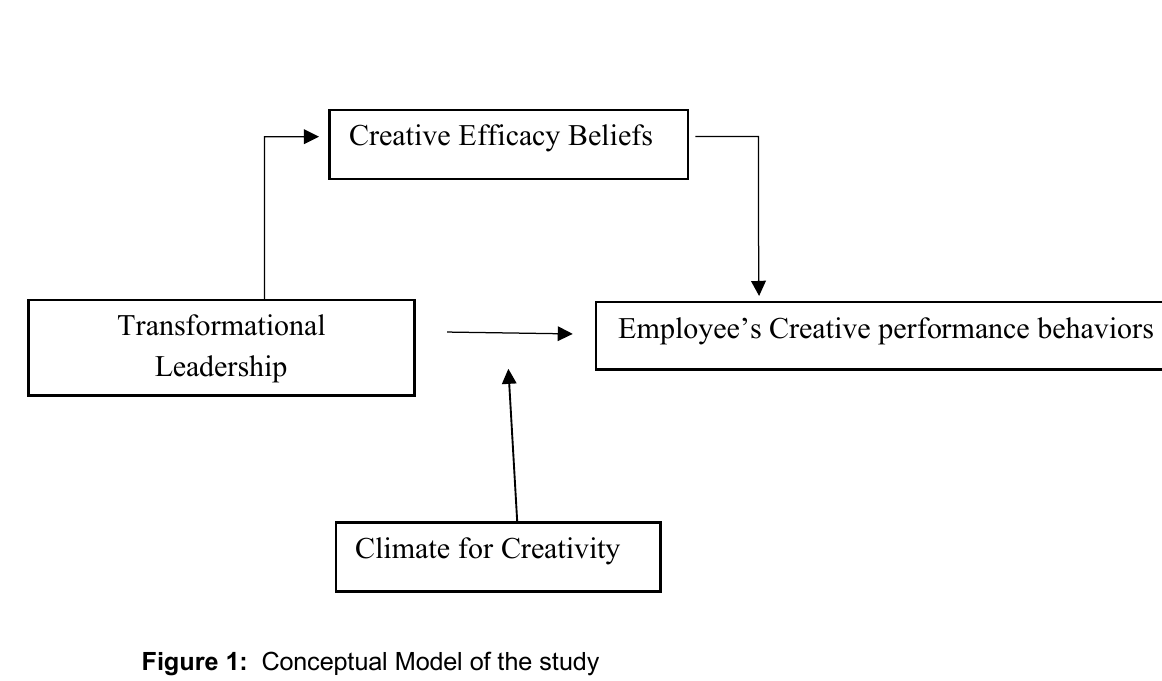
Figure 1: Conceptual Model of the study